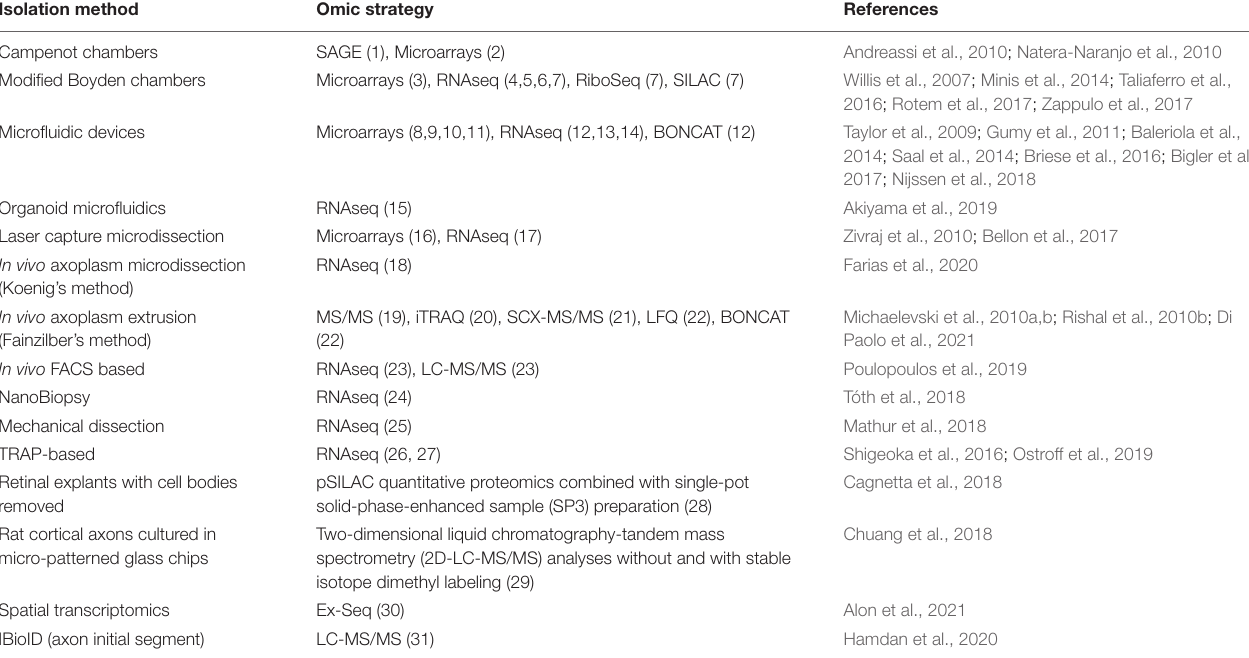
TABLE 1 | Summary of axon isolation methods implemented for omics